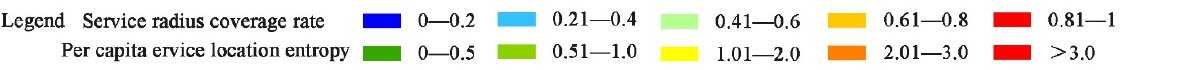
Figure 7. Evaluation of the social performance of Shanghai’s community sports and fitness